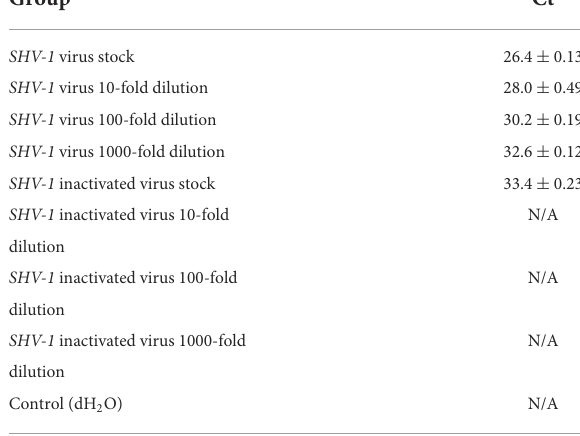
TABLE 5 Effectiveness of different virus dilutions on SHV-1